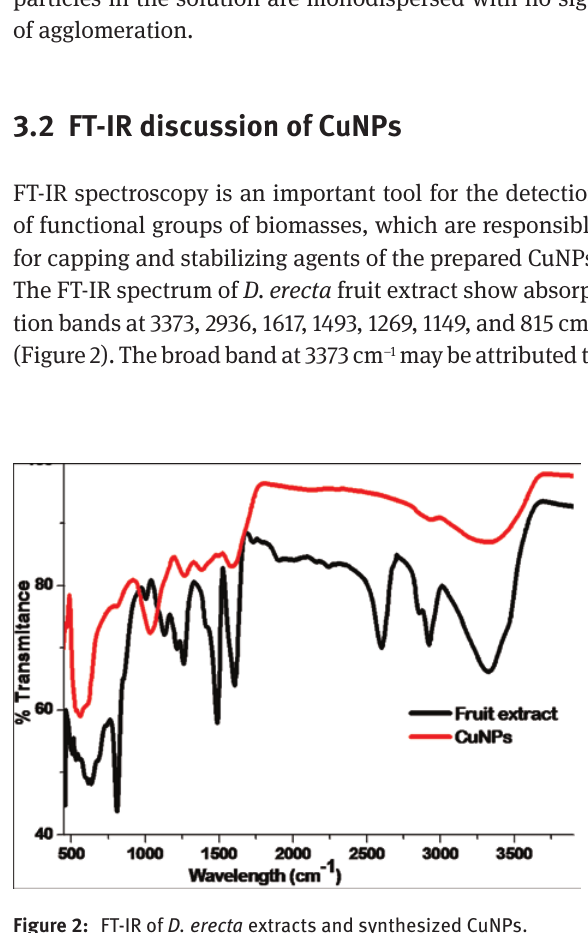
Figure 2: FT-IR of D. erecta extracts and synthesized